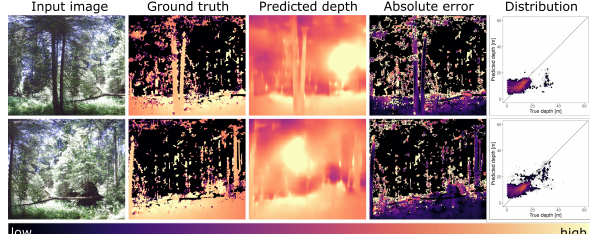
Figure 6. Challenging cases. The predicted depth maps are computed with our method using 500 input depth samples. The absolute errors range in [0m, 3m]. Most yellow areas in the absolute error maps correspond to leaves that were not filtered out during our de-noising procedure. Such areas are overestimated by our model, as shown in the plots in the last column. Yet, the prediction accuracy for tree stems and ground points remains high.